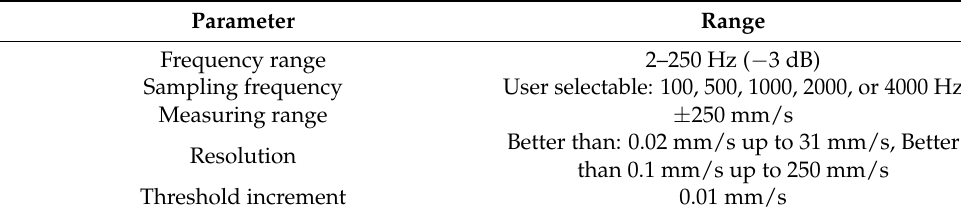
Table 1. Technical specifications of UVS 1608.